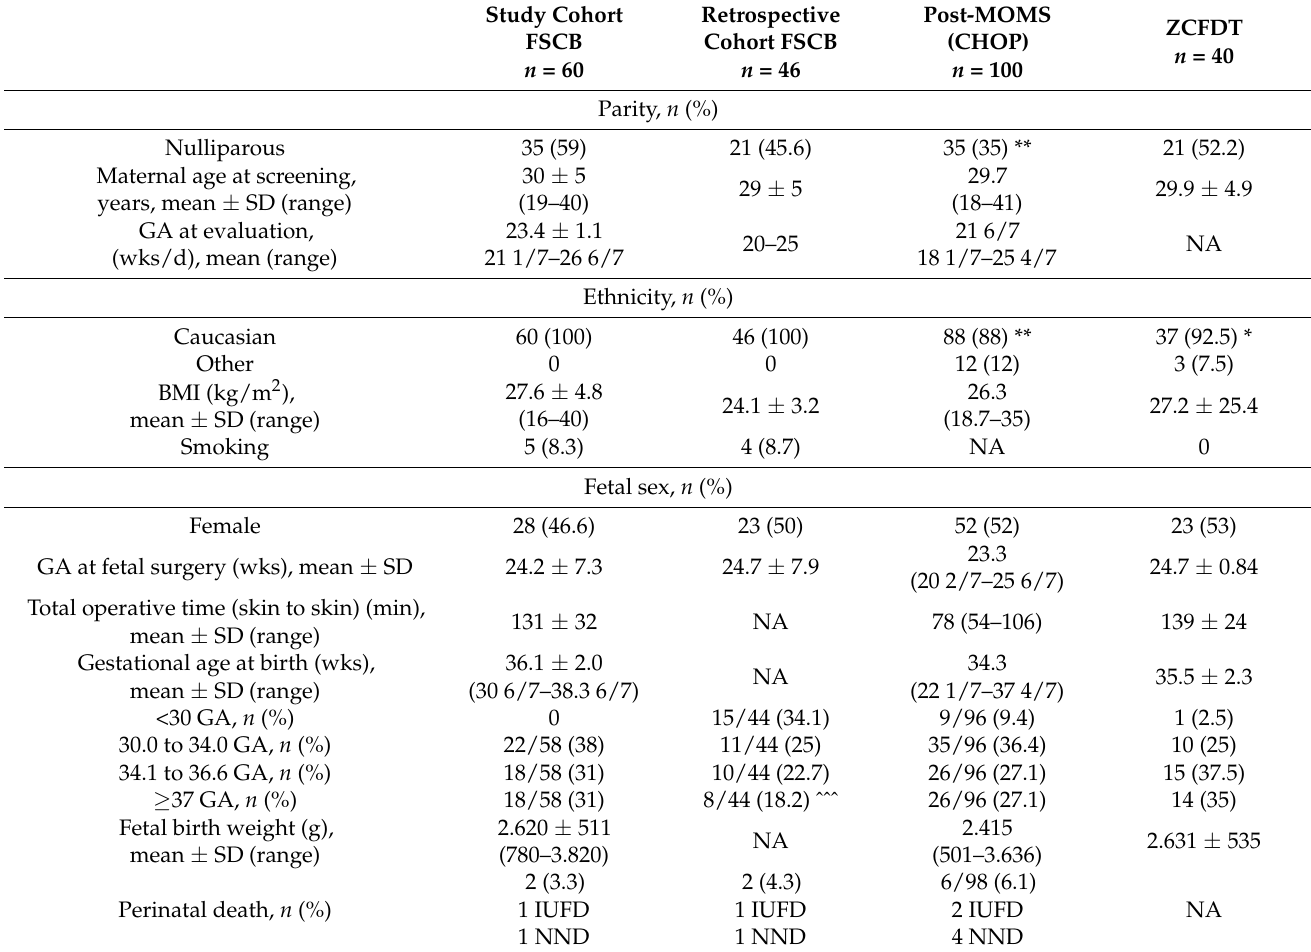
Table 1. Comparison of patient demographic and clinical characteristics from all cohorts.